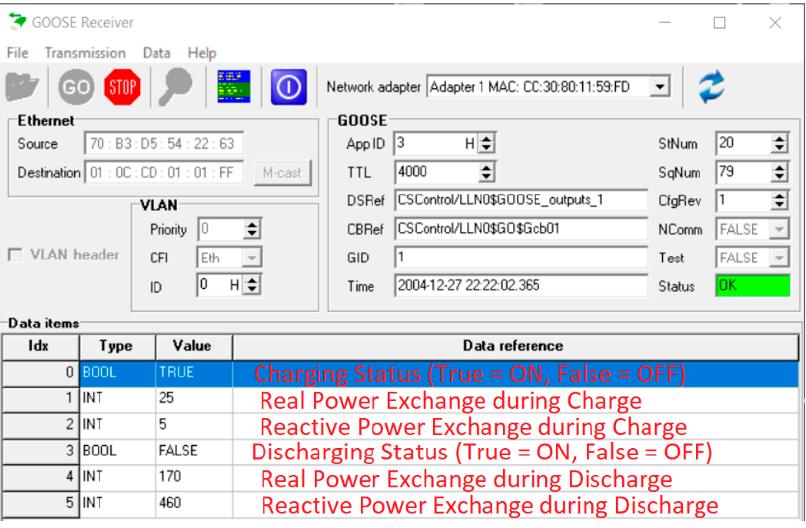
Figure 7. GOOSE message received by the EV, charge command, P = 25, and Q = 5.